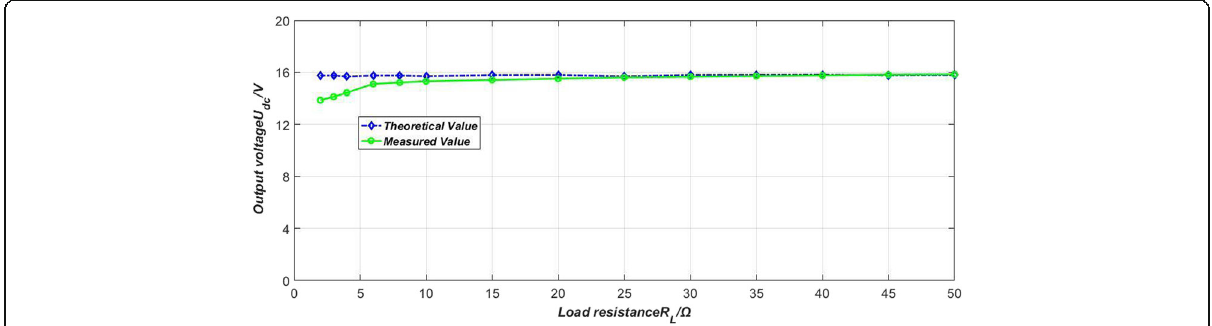
Fig. 16 Test results of output voltage with load resistance